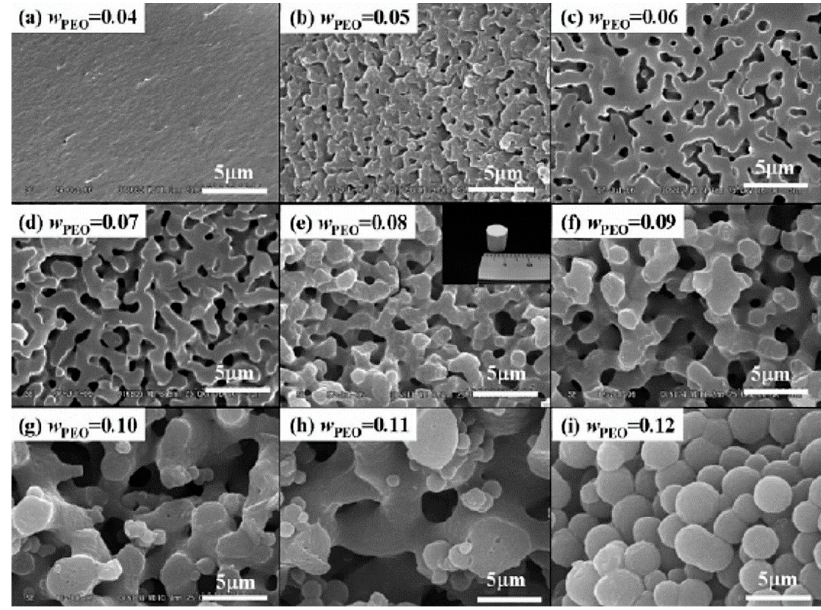
Figure 14. SEM photomicrographs of Al 2 O 3 dried monoliths prepared with different amounts of phase separation inducer additive, PEO (1,000,000 Mw). Reprinted (and adapted) with permission from Tokudome Y, Fujita K, Nakanishi K, Miura K, Hirao K (2007) Synthesis of monolithic Al 2 O 3 with well-defined macropores and mesostructured skeletons via the sol-gel process accompanied by phase separation. Chem Mater 19:3393–3398, doi:10.1021/cm063051p [76]. Copyright 2007 American Chemical Society.